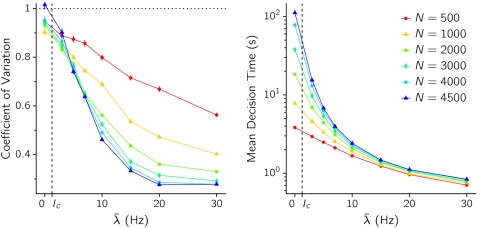
Coefficient of Variation (A) and mean value (B) of decision times versus the external input intensity λ̅, for different sizes of the network, as indicated in the key.
w
+ = 1.75.